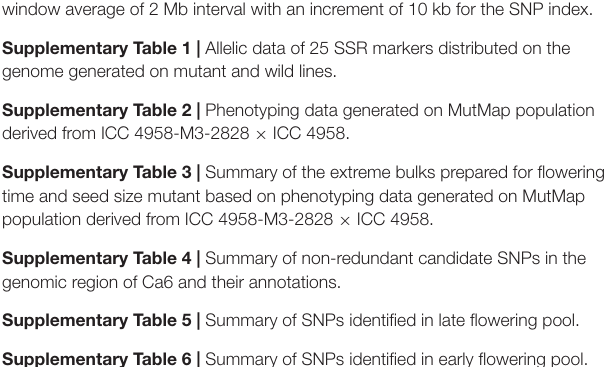
Supplementary Figure 1 | Dendrogram constructed based on the 25 SSR markers distributed across chickpea genome indicates more than 95% similarity between ICC 4958 (wild type) and ICC 4958-M3-2828. Supplementary Figure 2 | Frequency distribution and correlation among days to flowering and 100-seed weight. Histogram showing the frequency distribution of days to flowering (A) and 100-seed weight (B) . A negative correlation of 0.13 was observed between these traits. Supplementary Figure 3 | Single nucleotide polymorphism ( SNP) index plots for all eight pseudomolecules for early flowering pool. The red line indicates the sliding window average of 2-Mb interval with an increment of 10 kb for SNP index. Supplementary Figure 4 | Single nucleotide polymorphism index plots for all eight pseudomolecules for late flowering pool. The red line indicates the sliding window average of 2 Mb interval with an increment of 10 kb for SNP index. Supplementary Figure 5 | Single nucleotide polymorphism index plots for all eight pseudomolecules for large seed size pool. The red line indicates the sliding window average of 2 Mb interval with an increment of 10 kb for SNP index. Supplementary Figure 6 | Single nucleotide polymorphism index plots for all eight pseudomolecules for small seed size pool. The red line indicates the sliding window average of 2 Mb interval with an increment of 10 kb for the SNP index. Supplementary Table 1 | Allelic data of 25 SSR markers distributed on the genome generated on mutant and wild lines. Supplementary Table 2 | Phenotyping data generated on MutMap population derived from ICC 4958-M3-2828 × ICC 4958. Supplementary Table 3 | Summary of the extreme bulks prepared for flowering time and seed size mutant based on phenotyping data generated on MutMap population derived from ICC 4958-M3-2828 × ICC 4958. Supplementary Table 4 | Summary of non-redundant candidate SNPs in the genomic region of Ca6 and their annotations. Supplementary Table 5 | Summary of SNPs identified in late flowering pool. Supplementary Table 6 | Summary of SNPs identified in early flowering pool. Supplementary Table 7 | Summary of SNPs identified in large seed size pool. Supplementary Table 8 | Summary of SNPs identified in small seed size pool. Supplementary Table 9 | Details of primer pairs designed for candidate